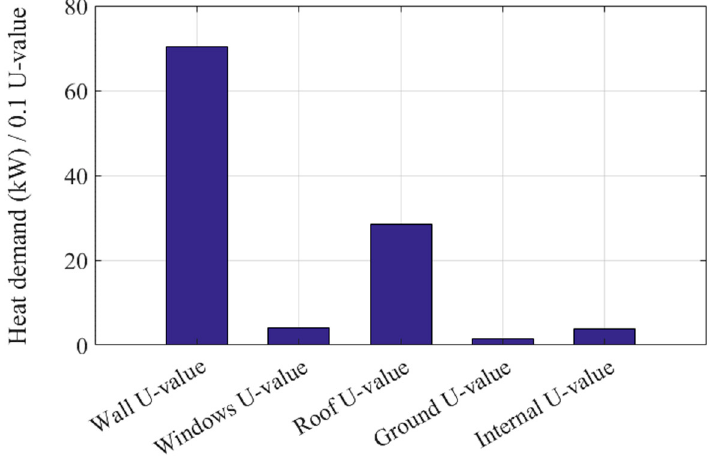
Figure 9. Elementary e ff ect sensitivity analysis of each calibrated parameter.